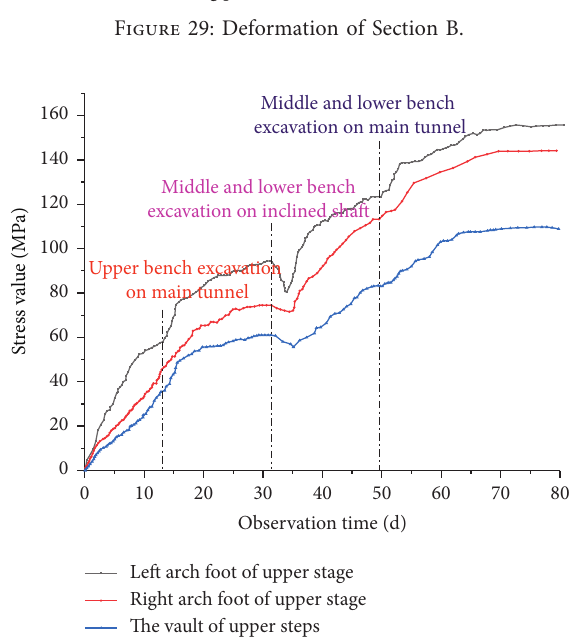
Figure 29: Deformation of Section B.